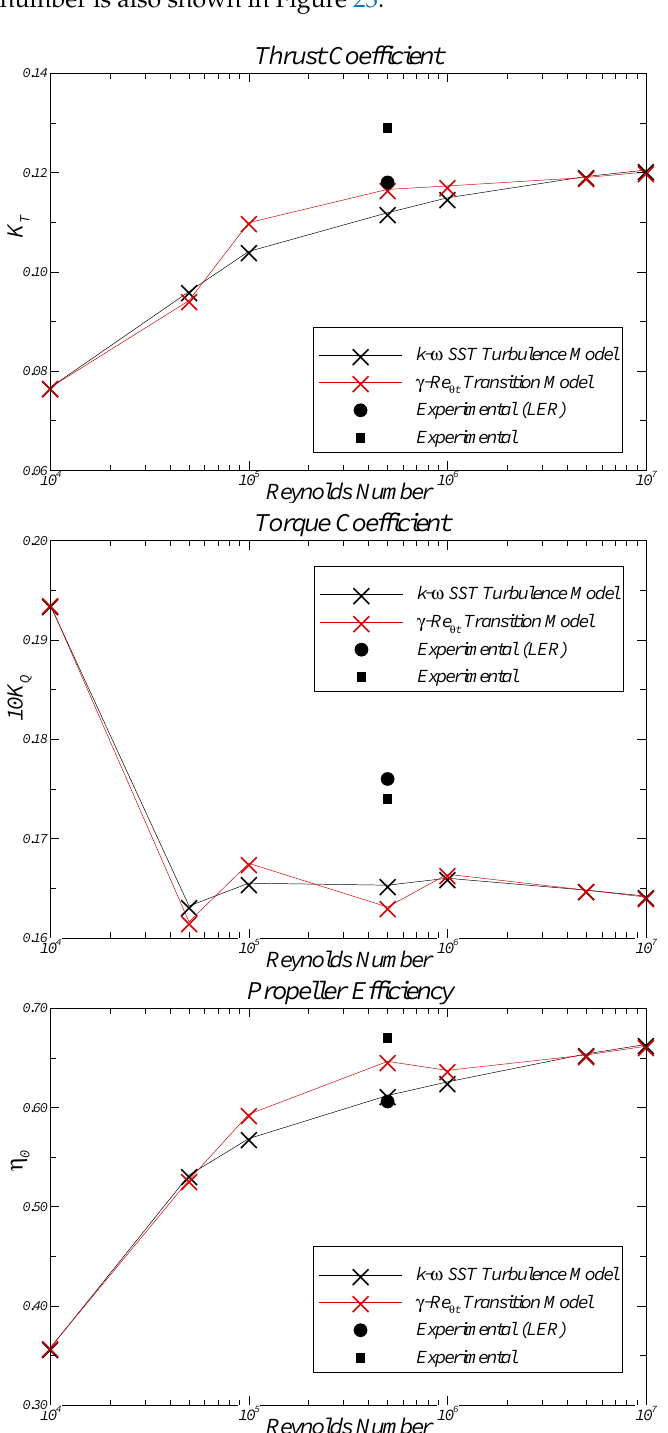
Figure 23. Propeller performance prediction for different Reynolds numbers at J = 0.568 using the k − ω SST turbulence model and the γ − ˜Re θ